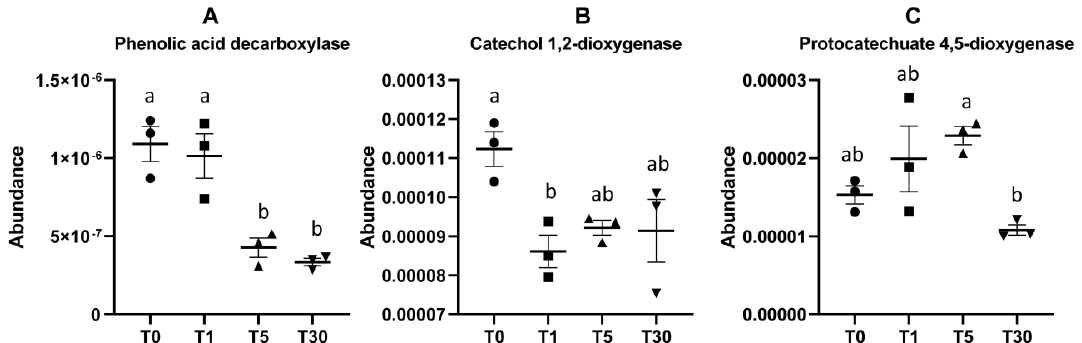
Figure 7. Relative abundance of enzyme-encoding genes involved in the phenolic acid degradation pathway. ( A – C ) Three key enzyme genes encoding phenolic acid decarboxylase, catechol